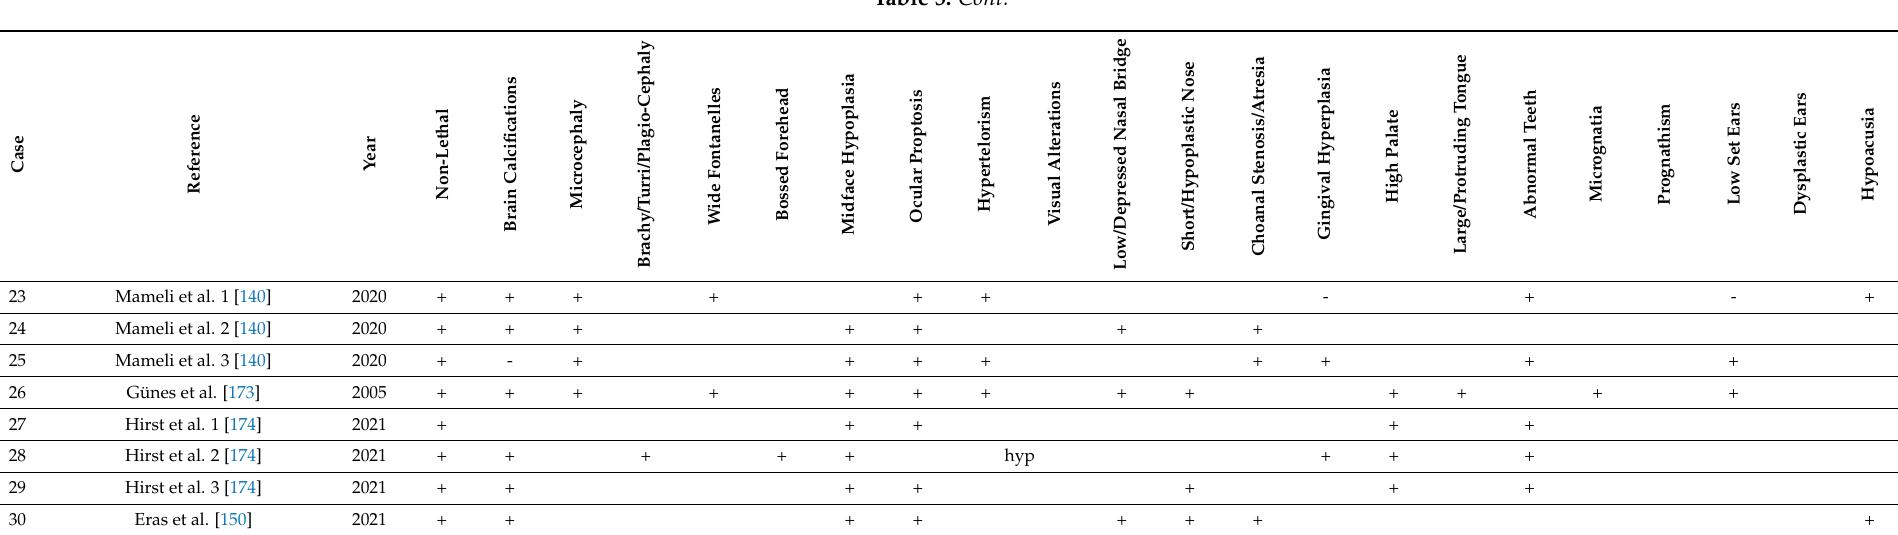
Hyp: hypotelorism. Empty cell: Not described or negative